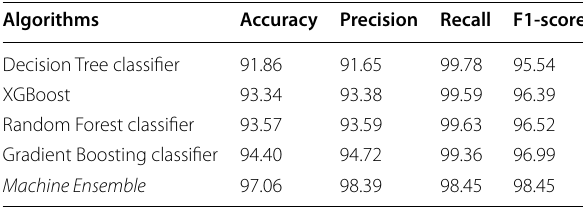
Table 1 Achieved Results (%) using binary classification of anomalies